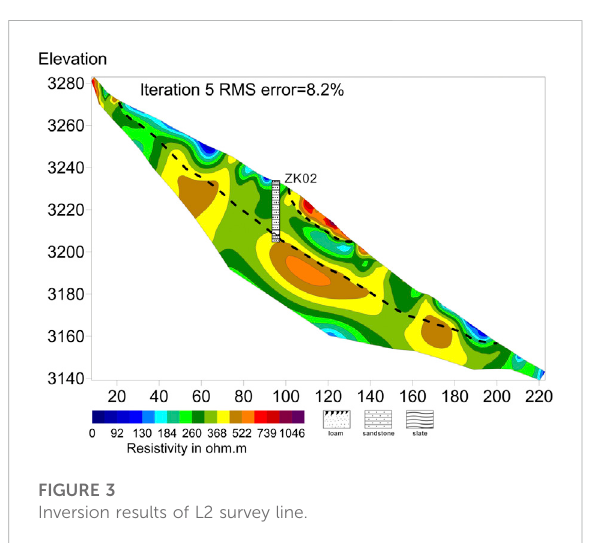
FIGURE 3 Inversion results of L2 survey